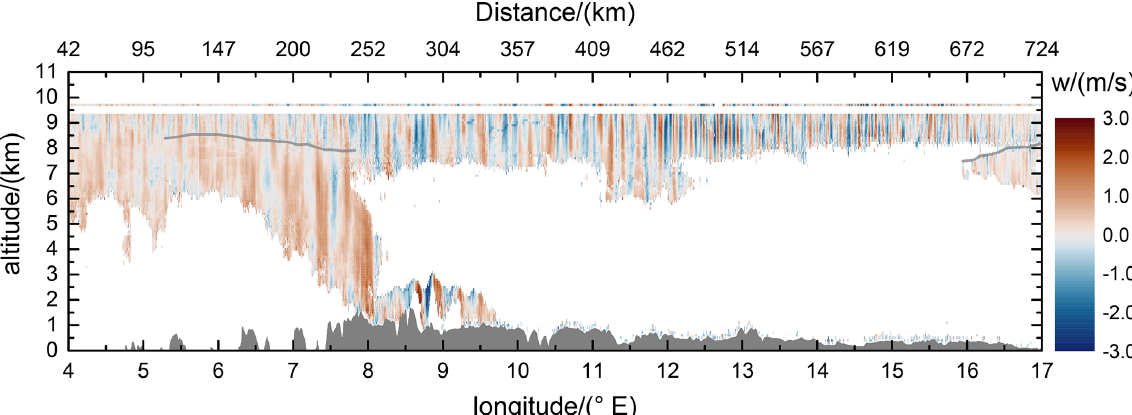
Figure 5. Vertical wind speed derived from 2µmDWL observations acquired in vertical wind mode on the flight leg FL2 flown on 28 Jan- uary 2016 (see also Table 1 and Fig. 1). The corresponding vertical wind measured in situ by the Falcon nose boom is indicated by the thin line at flight level. The surface elevation is sketched by the gray area at the bottom of the graph. The light gray line between 7 . 5 and 8 . 5km altitude indicates the position of the TIL, where the spectral properties of the GWs can be seen to change